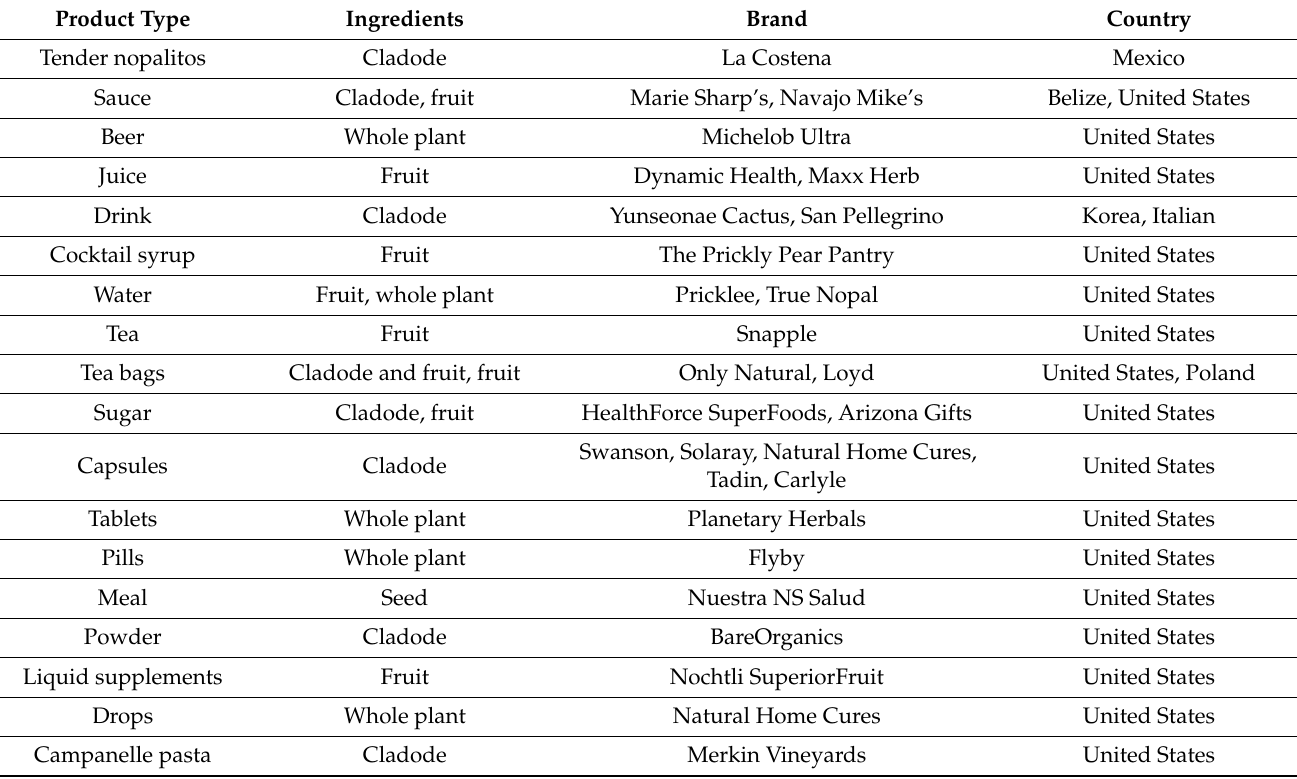
Table 3. Selected examples of marketed Opuntia ficus-indica products.